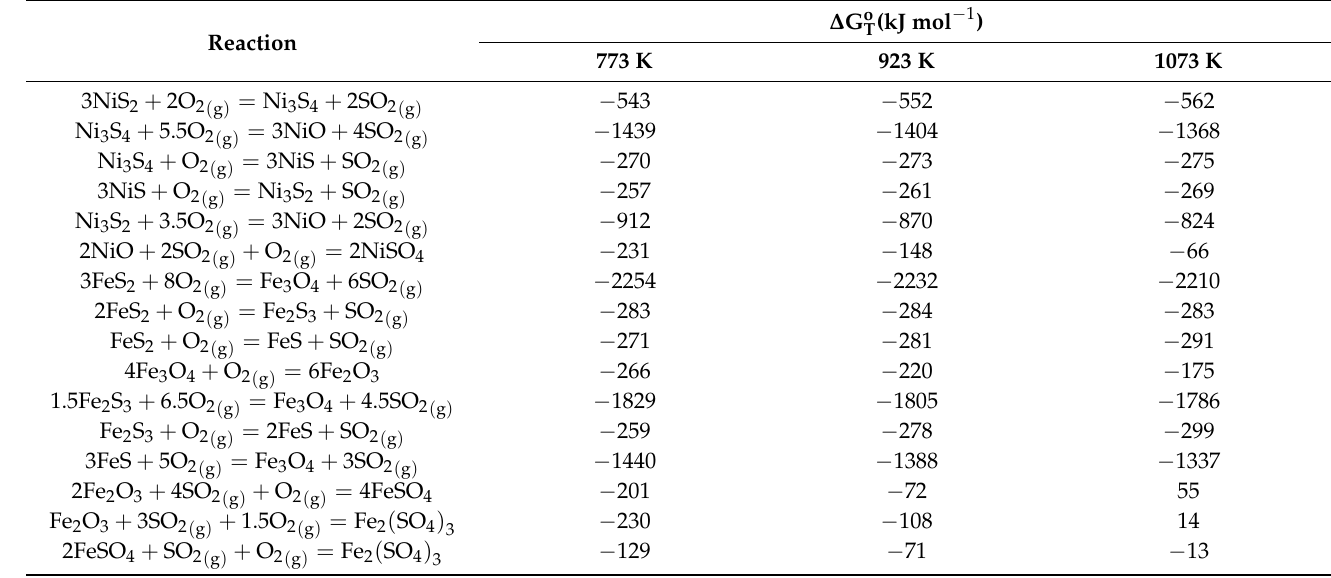
Table 4. Values of change in Gibbs free energy calculated for theoretically proposed reactions for Ni-S-O and Fe-S-O systems [37].